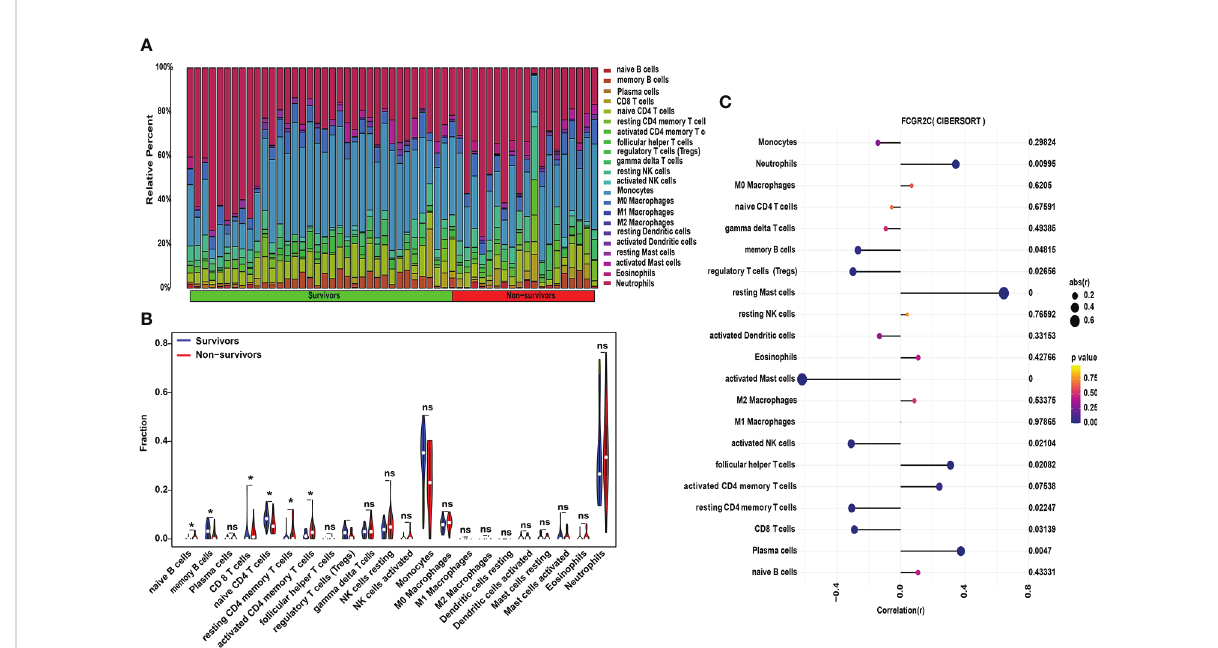
FIGURE 7 Immune cell analysis with CIBERSORT in the discovery cohort. (A) The relative percentages of 22 subpopulations of immune cells in septic patients. (B) The difference in immune cells between septic survivors and non-survivors. (C) Correlation analysis of FCGR2C with 22 immune cells. Dots indicate the intensity of the correlation, and different colors indicate the P-value. (*P< 0.05, ns: no signi fi